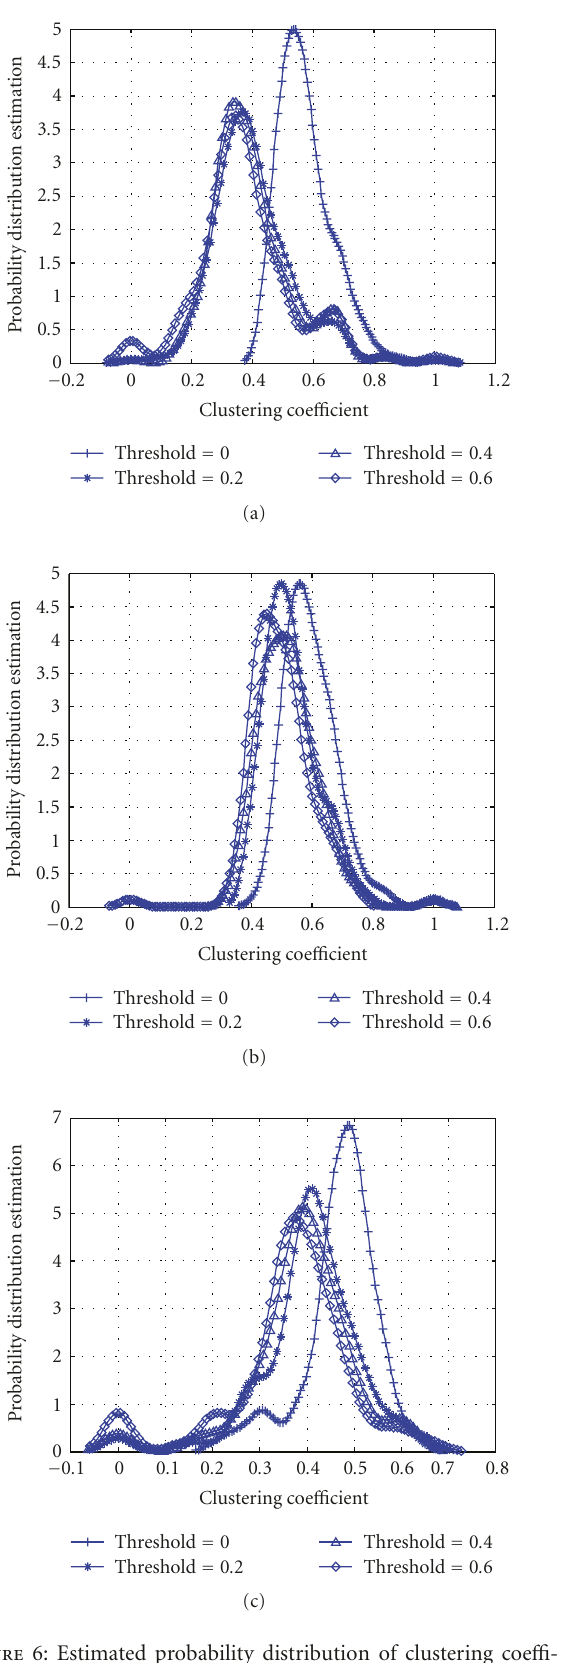
Figure 7: Power law for distribution of clustering coe ffi cient: (a) simulation data; (b) dataset A; (c) dataset